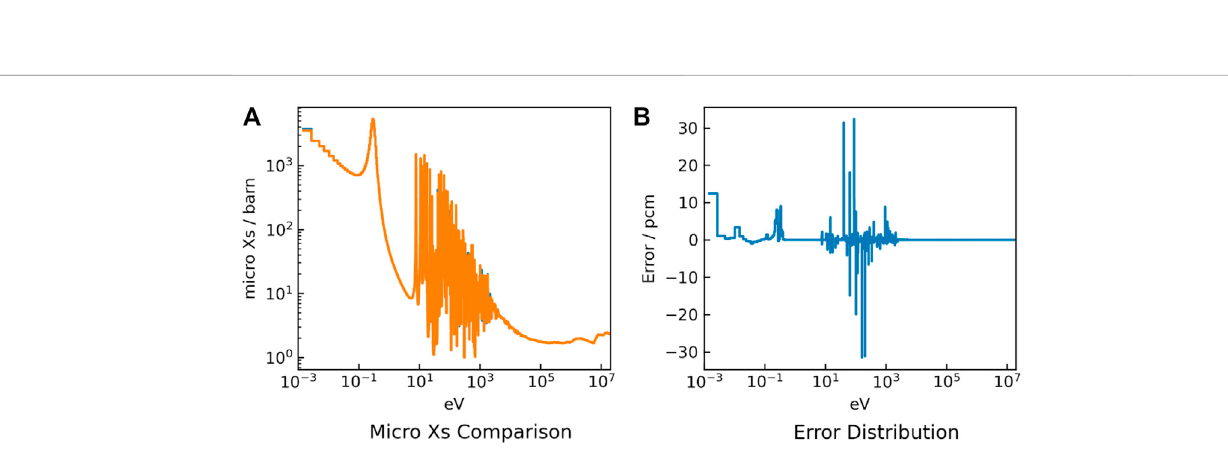
FIGURE 5 239 Pu absorption cross section results (A) and errors (B) for the MOX problem with thermal spectrum.